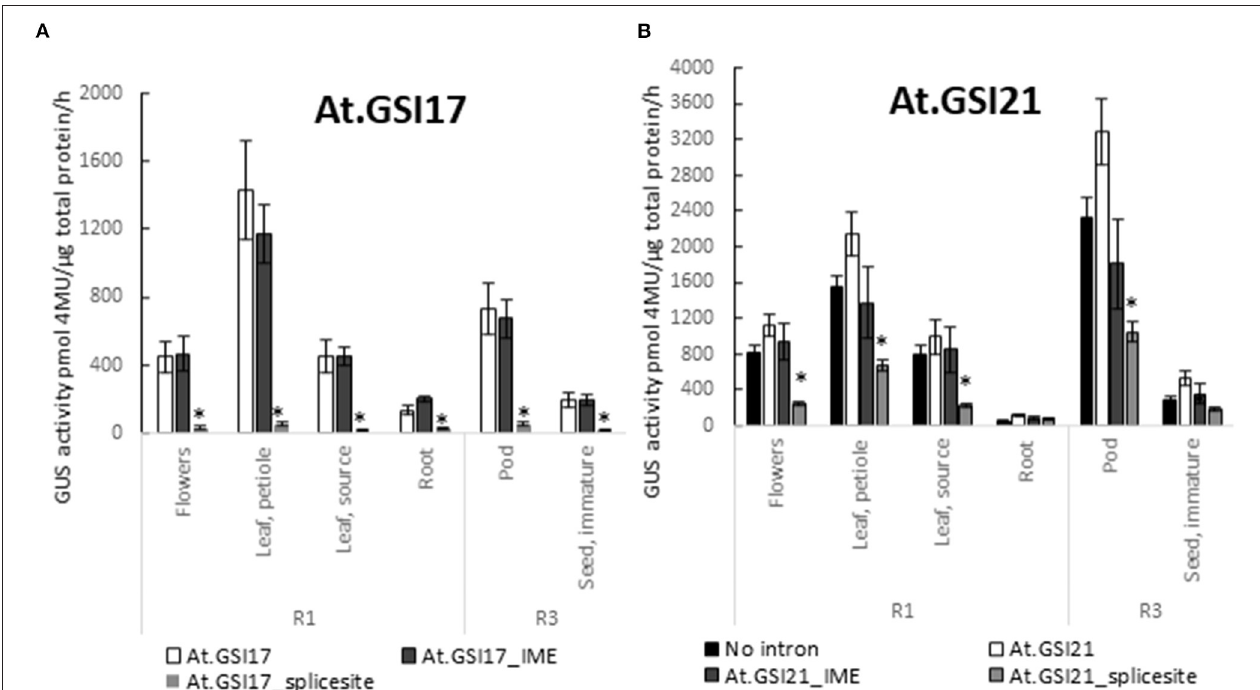
FIGURE 6 | GSIs require intron motifs for function. Expression of GUS reporter genes in the IME motif and splice site variants of GSIs was compared with the original At.GSI17 (A) and At.GSI21 (B) introns. At.GSI17_IME and At.GSI21_IME intron variants were generated by introducing transversions in the IME motifs and splicing motifs in the respective intron sequences ( Supplementary Material S1 ). Intron variants were tested in the same context as the original introns as in Figure 5 . GUS reporter gene activity was performed on various tissues from transgenic soybean plants at R1 and R3 stages. GUS enzyme activity on MUG substrate was normalized to total protein and reported as pmol 4-MU/ µ g total protein/h. At least six independent transgenic events were analyzed, and the data are reported as the mean with standard error. *Indicates a statistically significant difference between original and mutant variants when compared in the same tissue type with p -value threshold corrections to control for false discovery < 0.05 in multiple